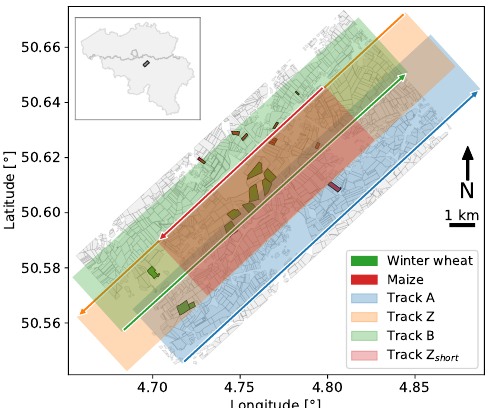
Figure 2. The BELAIR Hesbania test site, with the winter wheat and maize fields in green and red, respectively, and all the other agricultural fields inventoried on the anonymous cadastral map for agricultural land provided in Wallonia’s land-parcel identification system (Système Intégré de Gestion et Contôle (SIGeC)) in grey. The four parallel flight tracks are represented by colored